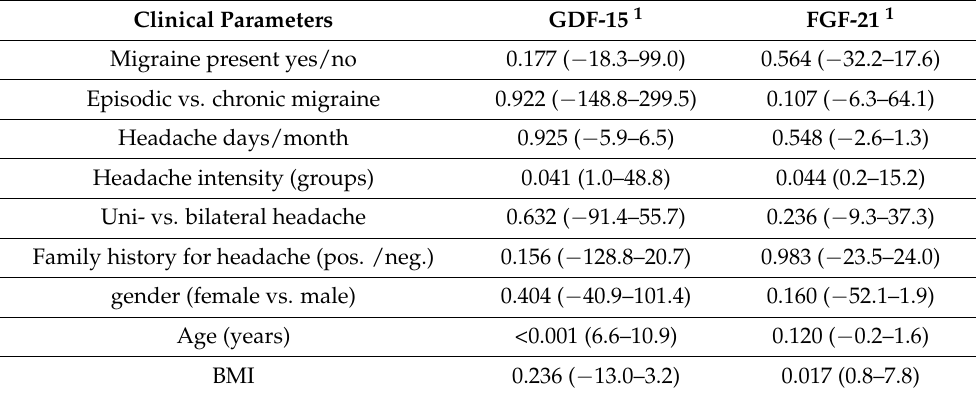
Table 3. Multiple linear regression of GDF-15 and FGF-21 concentrations p -values were calculated using multiple regression. Additionally, the 95% confidence intervals of the biomarker concentrations in pg/mL are given in brackets. For example, there is a highly significant correlation between age and GDF-15 with an increase in GDF-15 of 6.6–10.9 pg/mL per year. This type of reading applies to all metric-scaled parameters (headache days, age and BMI). Grouped analyses were performed for all other parameters. The p -values are stratified for each clinical parameter listed in this table.